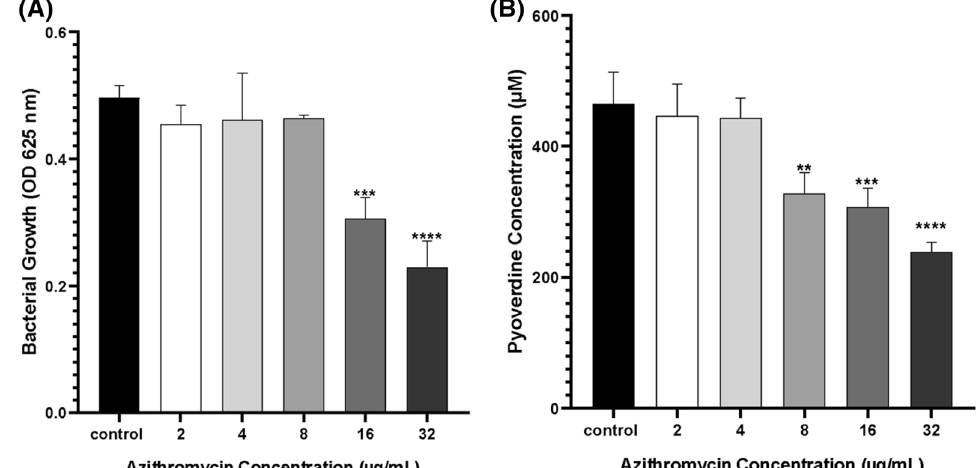
Fig. 2 Concentration‑dependent effect of azithromycin (0–32 µg/mL) on A P. aeruginosa growth after 24 h incubation. B Level of pyoverdine (µM) production by P. aeruginosa after 24 h incubation. Error bars indicate SD from three independent replicates. Data was analysed by one‑way ANOVA followed by the Dunnett test as post‑hoc. Significance in comparison to control is expressed as ** P ‑value **** P